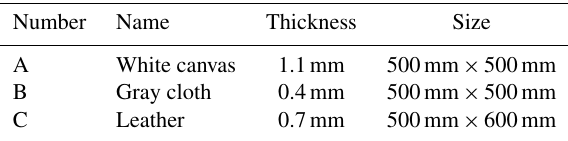
Table 1. Size parameter table of grabbing fabric.